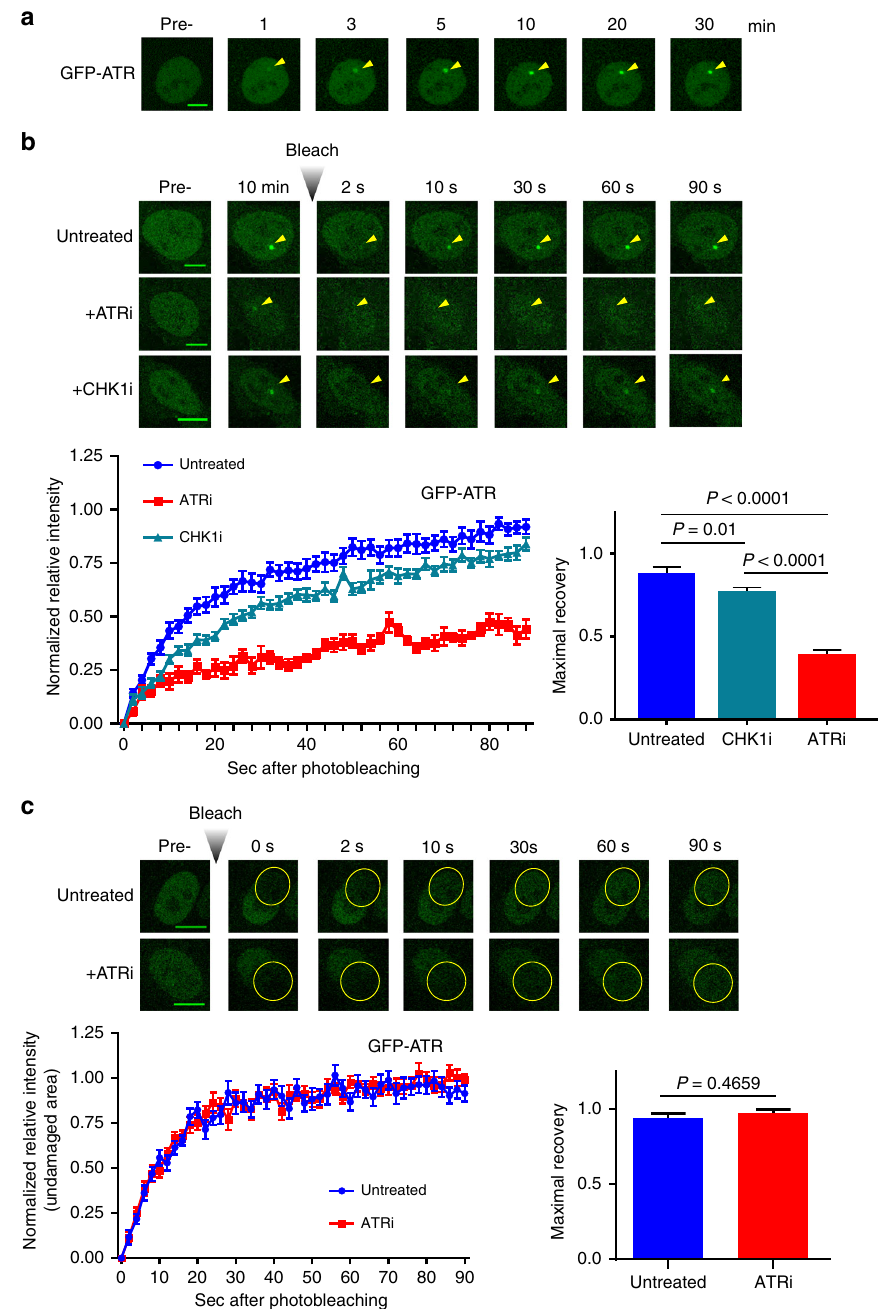
Fig. 3 The rapid exchange of ATR on damaged DNA is dependent on its kinase activity. a The kinetics of GFP-ATR recruitment to sites of DNA damage. U2OS cells stably expressing GFP-ATR were monitored by confocal microscopy at the indicated time points after micro-irradiation (405 nm). Images of a representative cell are shown (scale bar is 10 µ m). b FRAP analysis of GFP-ATR in U2OS cells after laser-induced foci formation, untreated or following treatment with ATRi (VE-821) or CHK1i (LY2603618) at 10 µ M concentration. After photobleaching, recovery of the focus signal was monitored up to 90 s. The means ± SEM of the maximal recovery of GFP-ATR are reported for every condition analyzed and unpaired two-tailed t test was used for the statistical analysis. Representative cells are shown. Scale bar is 10 µ M. c Quanti fi cation of the recovery of GFP-ATR relative intensity in an undamaged area after bleaching, in untreated or ATRi treated U2OS cells. The means ± SEM of the maximal recovery of GFP-ATR are reported and unpaired two-tailed t test was used for the statistical analysis. Representative cells are shown. Scale bar is 10 µ M. Source data are provided as a Source Data fi